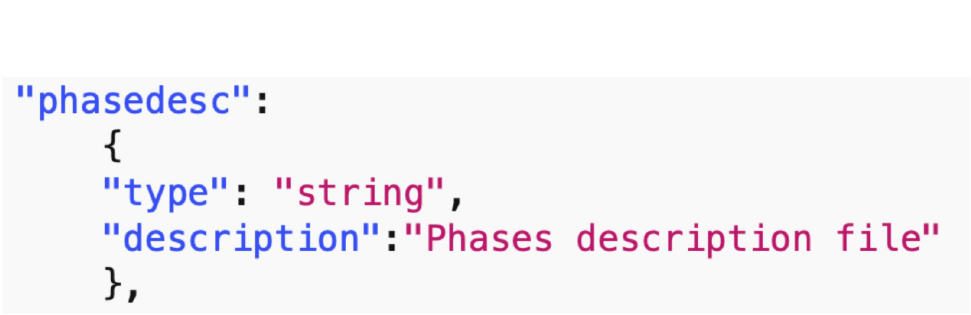
Fig 24. To run a pipeline (called a job), a configuration input file specifies functions and their order of execution. This figure shows a portion of the schema for a configuration file that specifies the experiment JSON schema file location.